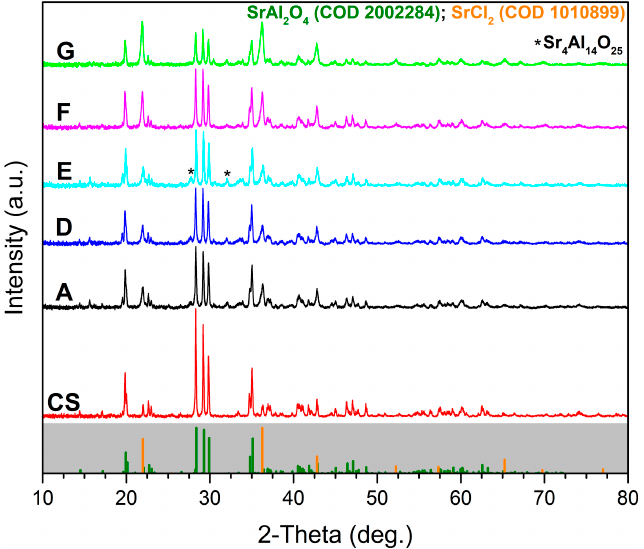
Figure 5. X-ray diffraction patterns of the obtained samples (A, D–G) and commercial sample (CS) samples (color codes: CS—red, A—black, D—blue, E—turquoise, F—magenta, G—green).